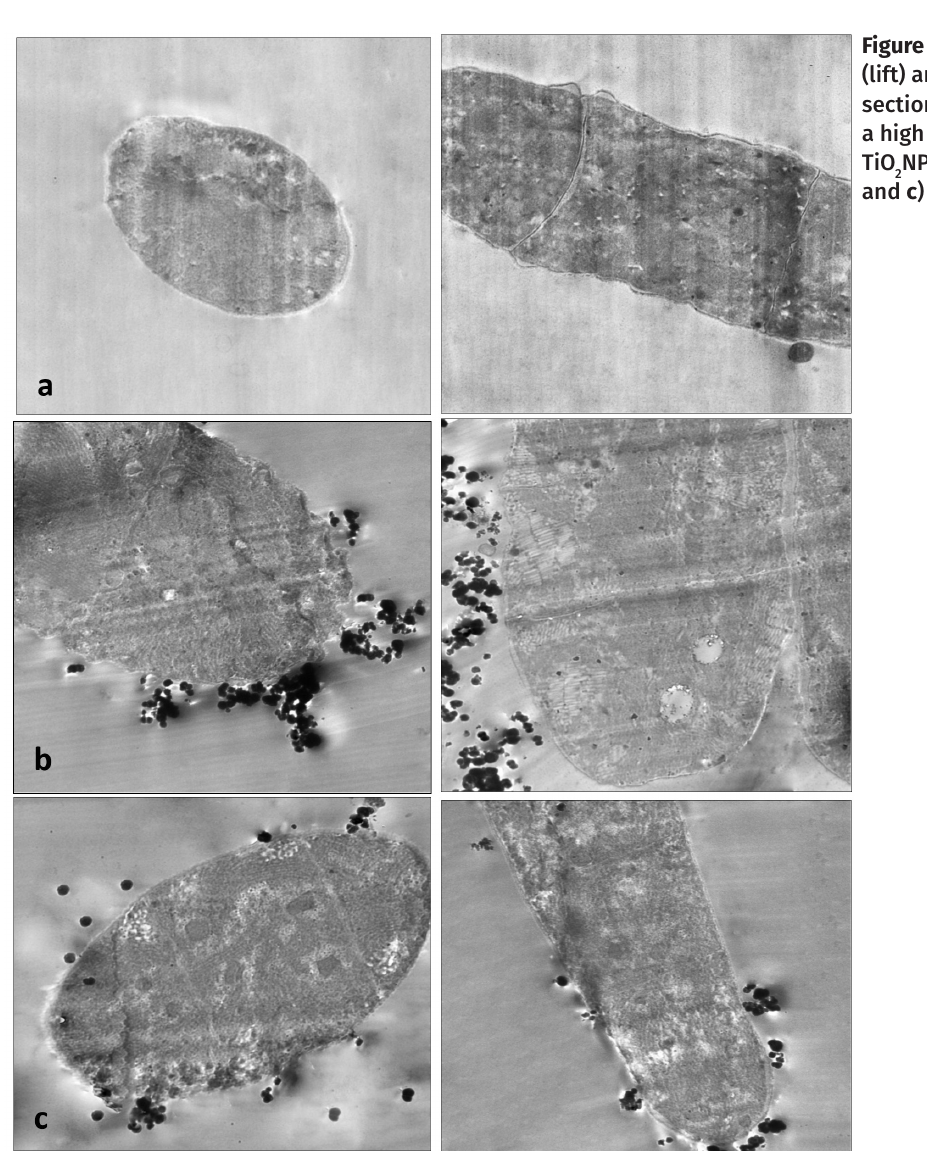
Figure 6. TEM images of cross (lift) and longitudinal (right) sections of S. platensis with a high degree of attached NPs– MG at a ) 0 h, b ) 24 TiO 2 and c ) 48